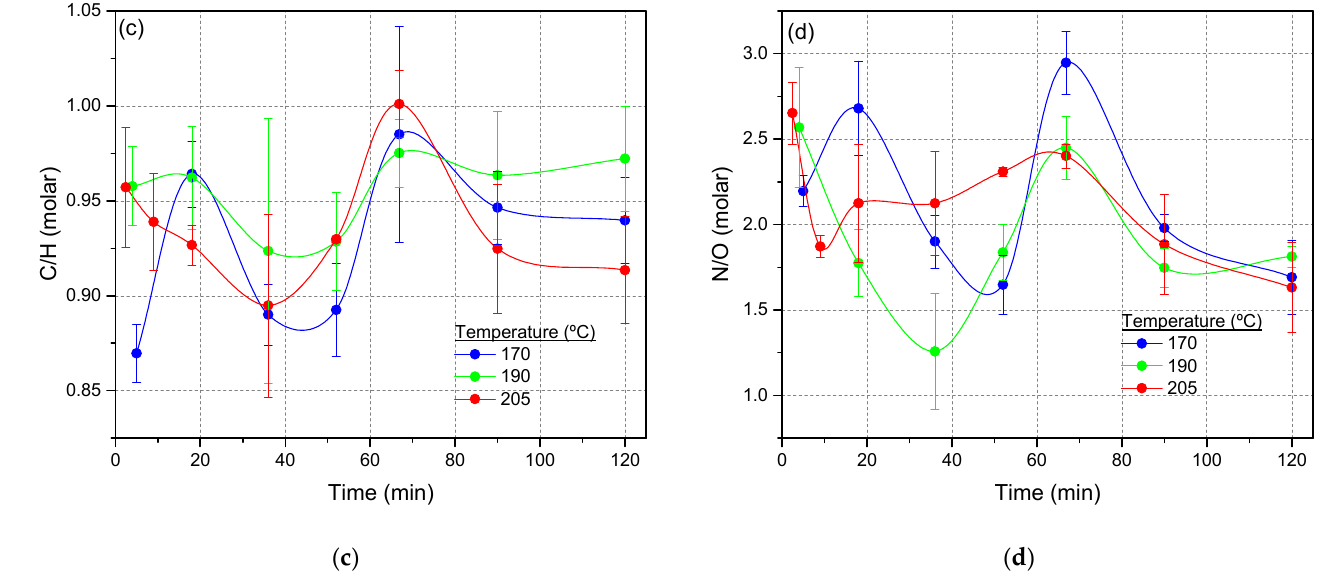
Figure 2. Evolution of the molar relationships for the three series of experiments carried out using MWR against reaction time (for details, please see Table S2). ( a ) C/N molar relationships; ( b ) C/O molar relationships; ( c ) C/H molar relationships and ( d ) N/O molar relationships. These molar relationships represent the average values of three independent samples for each reaction condition.